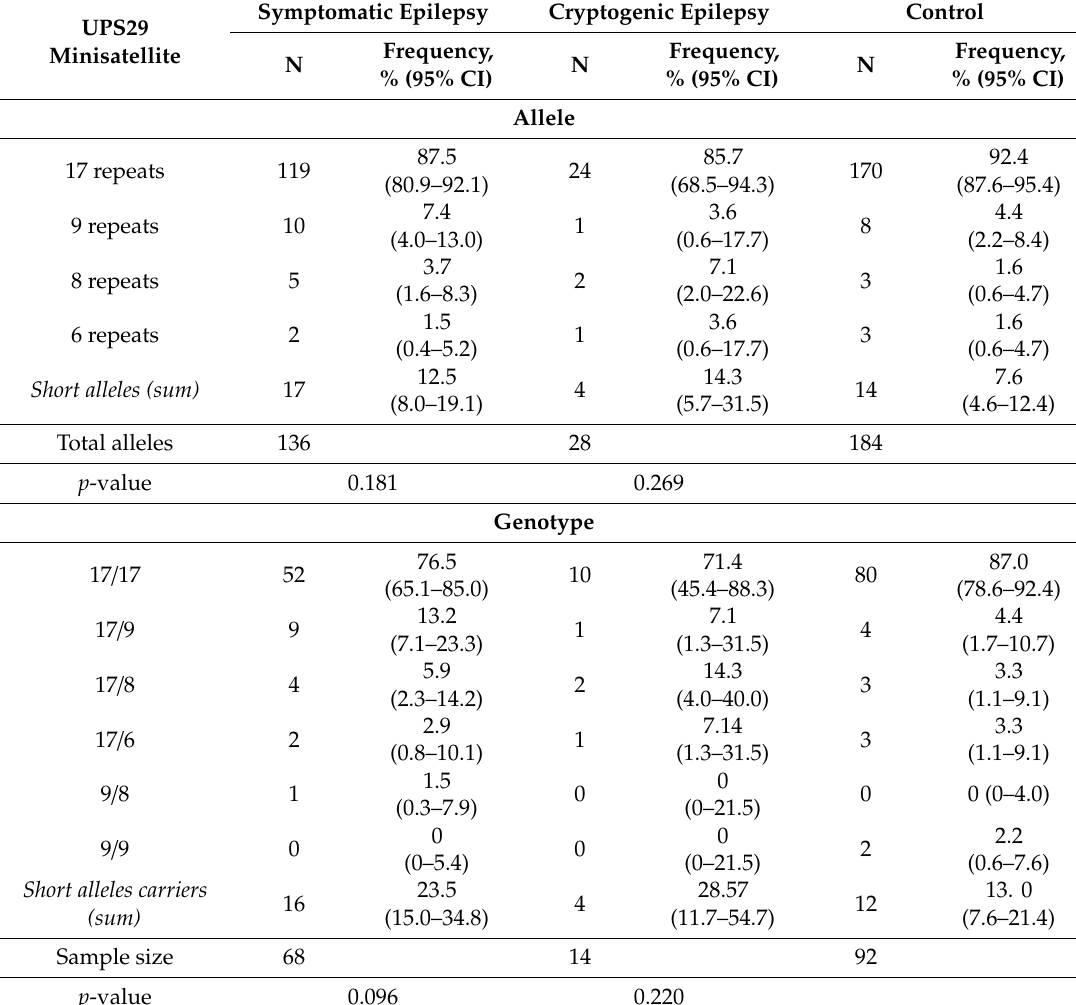
Table 1. Allele and genotype frequency of UPS29 in men with epilepsy (symptomatic and cryptogenic) compared with healthy